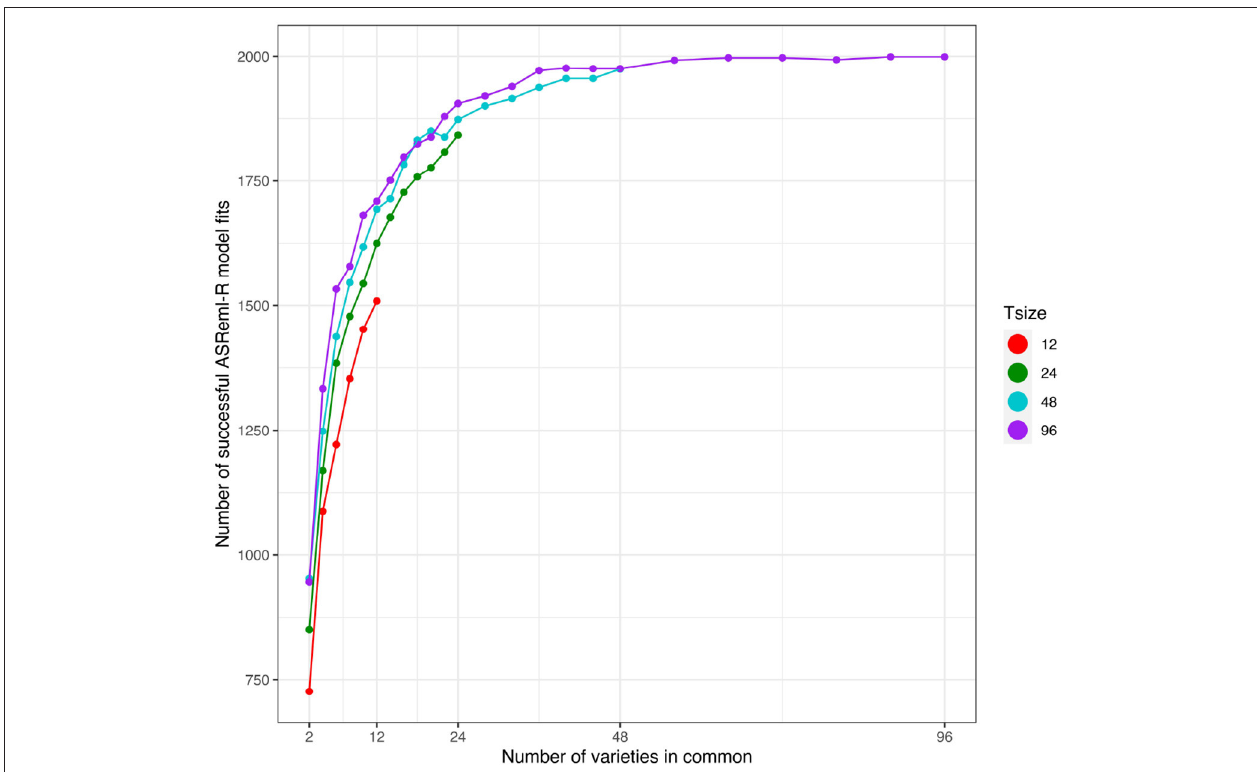
FIGURE 4 | Independent VE effects simulation study: Number of successful model fits from N = 2,000 simulations plotted against number of varieties in common for four trial sizes (trials with 12, 24, 48, and 96 varieties). Trial sizes (Tsize) are represented using different colours. Each point within Tsize corresponds to a different level of variety connectivity which ranges from c = 2 up to the number of varieties in a trial (representing 100% connectivity between the two trials).